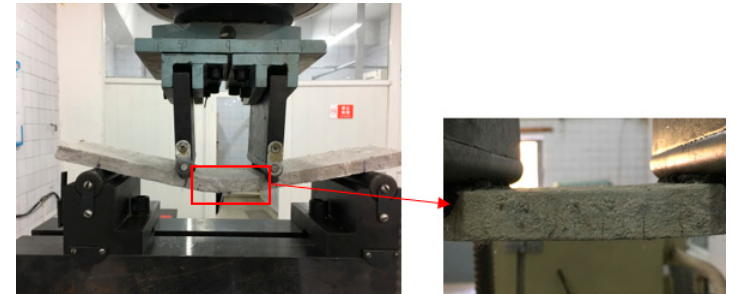
Figure 4. Four-point bending test.